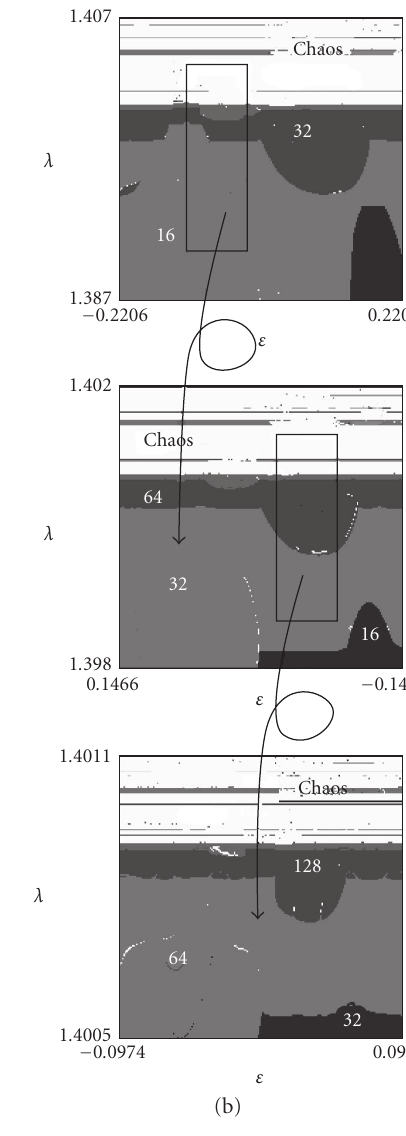
Figure 2.4. Illustrations of a scaling in the parameter space ( λ , ε ) for only dissipative (a) and inertial (b) couplings for the following values of rest parameters A = 1 . 1249, B = 0 . 375, which correspond to the bicritical point. Di ff erent tints of grey colour mean periodic behaviour, white area—chaos. Numbers mean the di ff erent periods of oscillations. One can see that after special rescaling we have a similar structure near the bicritical